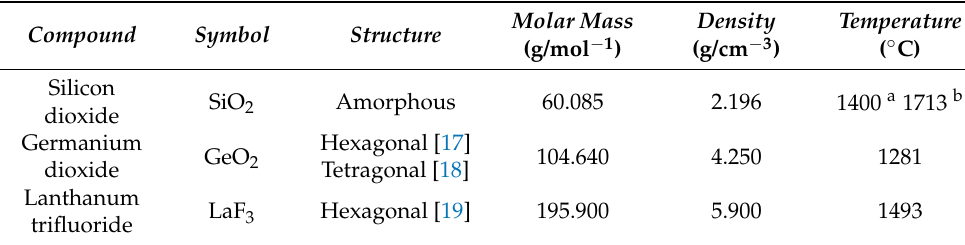
Table 1. Main physicochemical properties of the three studied compounds [16]. a Tg; b Mp.